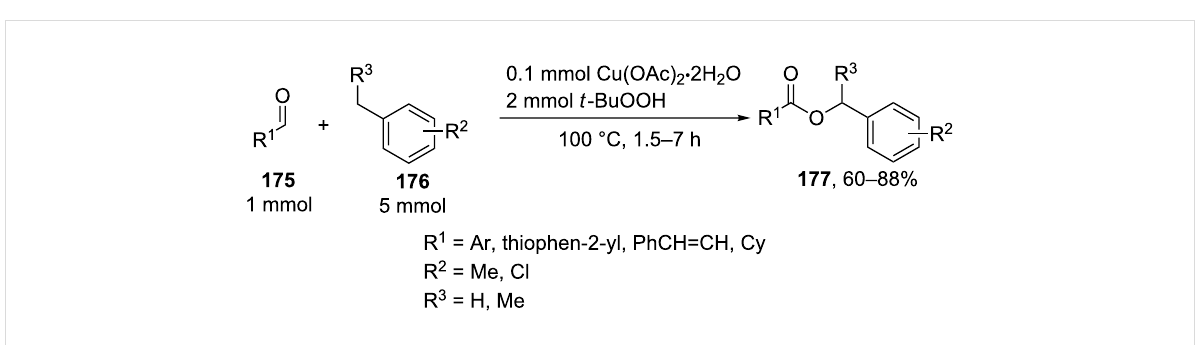
Scheme 36: Oxidative C–O coupling of aldehydes with alkylarenes using the Cu(OAc) 2 / t- BuOOH